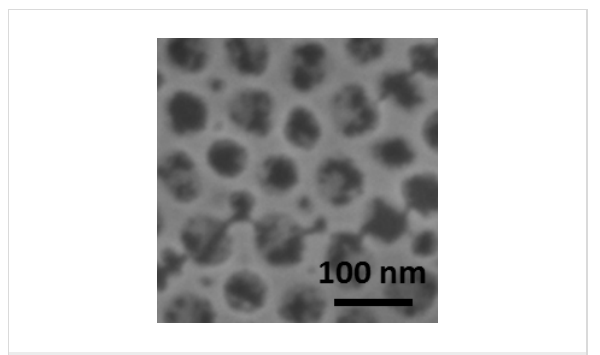
In order to verify the effectiveness of the gold functionalization through the MHA anchoring function at the bottom of the perfo- rations, the presence of sulfur atoms at the surface of the sample was monitored by X-ray photoelectron spectroscopy (XPS) throughout the functionalization step. XPS was carried out right after removing the sample from the MHA solution and after rinsing with EtOH (Figure 7). Before rinsing (Figure 7a), the spectrum exhibit two doublets that can be assigned to a free thiol function and a thiolate species bound to the gold surface [25,26]. After rinsing, the band characteristic of the free func- tion has disappeared (Figure 7b). But, the band corresponding to bound thiolate species still remains. The grafting of the gold surface with MHA therefore was successful.